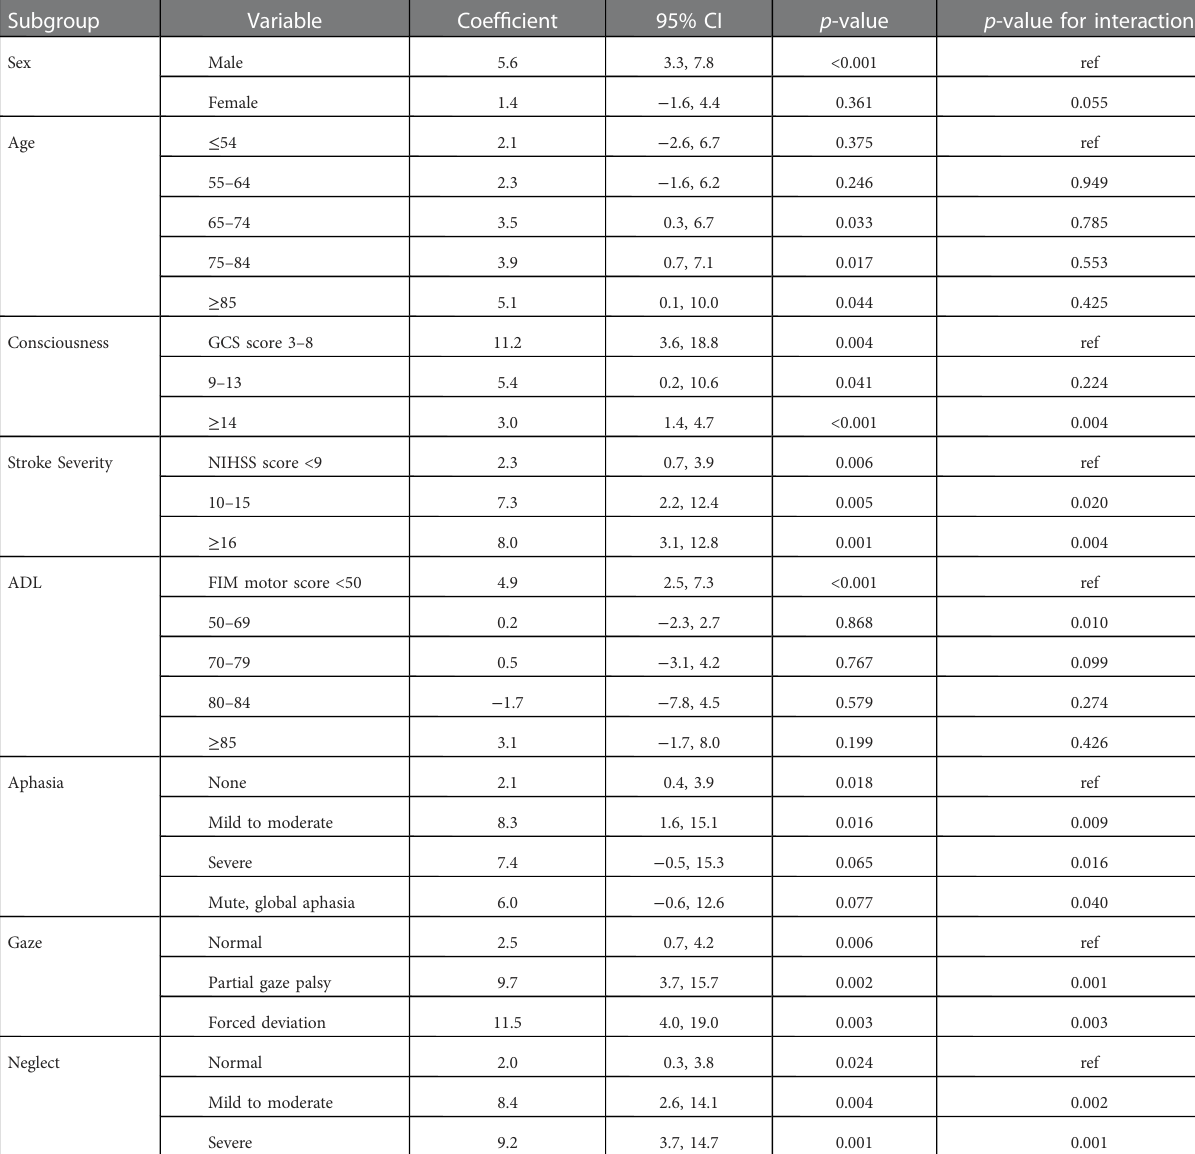
TABLE 4 Adjusted coef fi cients [95% con fi dence intervals (CI)] and interactions of the active occupational therapy group in terms of the gain in functional independence measures (FIM) score according to baseline patient characteristics after inverse probability of treatment weighting.